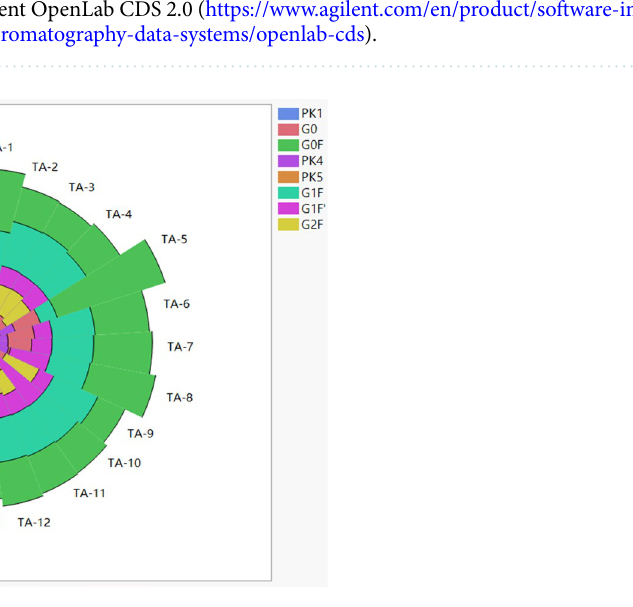
Figure 4. The pie chart of glycan percentage of samples and reference. TA-1 to TA-24 refers to the samples obtained from the designed 24-run experiment in Ambr. One sector represents one sample’s glycan distribution. The shadowed sector represents reference. The image was created by JMP V15 (http:// www. jmp.